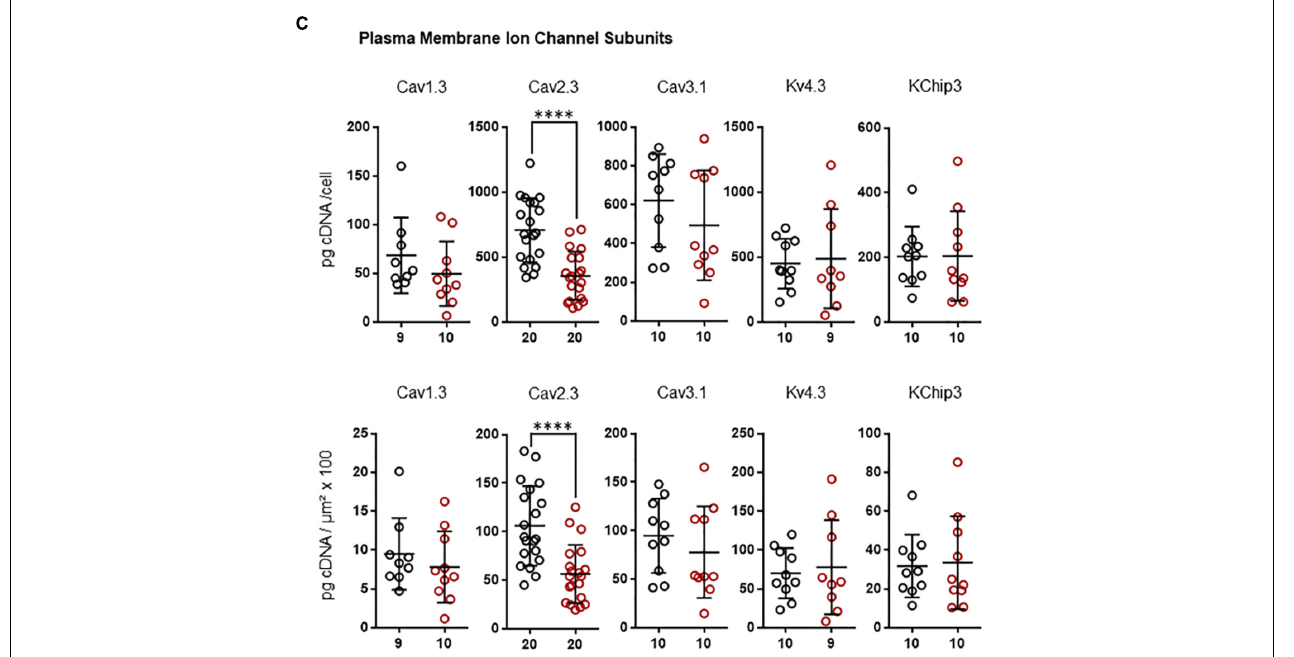
FIGURE 3 | Lower mRNA levels selectively of UCP4, UCP5, DJ-1, and Cav2.3 in SN DA neurons from NCS-1 KO mice compared to WT. Relative RT-qPCR-derived data from individual TH positive SN neurons from juvenile NCS-1 KO and WT mice (A) for mitochondrial uncoupling proteins UCP2, UCP4, UCP5 and mitochondrial Ca 2 + transporters MCU, and LETM1, (B) for the PD-associated PARK genes DJ-1, SNCA, PGC-1 α , GBA1, and (C) for the voltage-gated ion channel pore forming α -subunits Cav1.3, Cav2.3, Cav3.2, and Kv4.3, as well as for KChip3. Data are given relative to respective tissue cDNA-derived standard curves (in pg/cell, upper), and normalized to specific laser-microdissected neuron sizes (in µ m 2 × 100, lower), as scatter plots with mean ± SD. Cav2.3 data modified from Benkert et al. (2019). Significant differences are indicated according to Mann–Whitney U-tests and marked with asterisks ( ∗ p ≤ 0.05; ∗∗ p < 0.01; ∗∗∗ p < 0.001 and ∗∗∗∗ p < 0.0001). Numbers of analyzed individual SN DA neuron-derived cDNA samples (n) are given on the x-axis. All data and statistics detailed in Supplementary Table S3